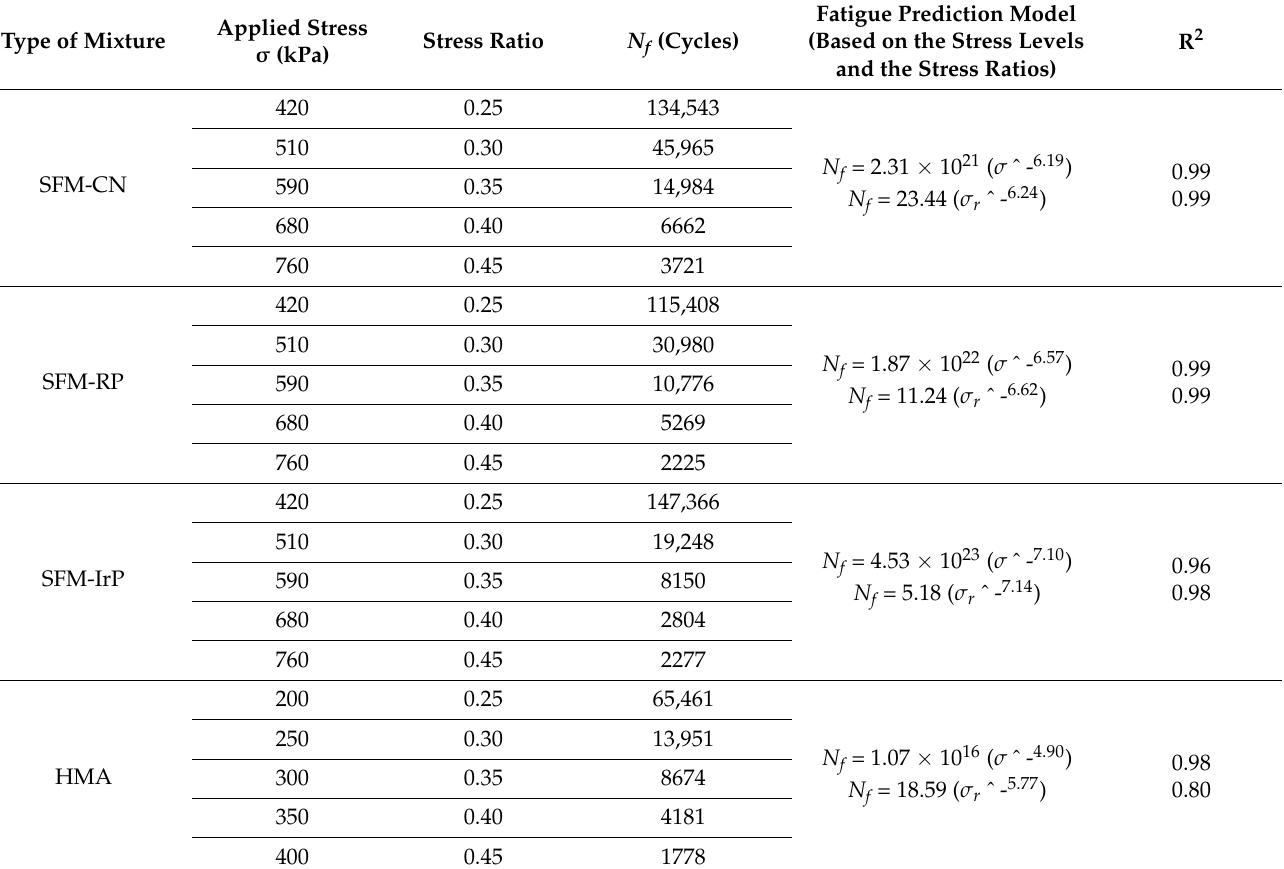
Table 2. Equations developed to predict fatigue